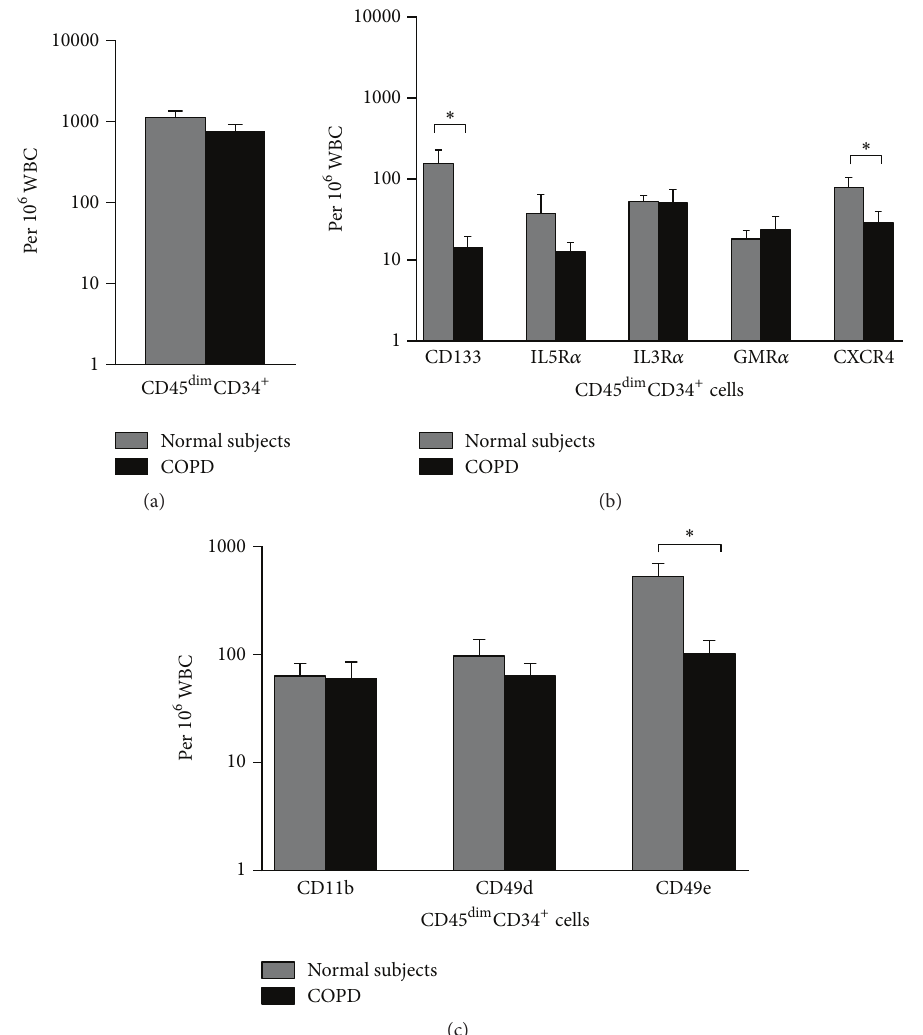
Figure 1: (a) Enumeration, (b) phenotyping, and (c) assessment of adhesion receptors by flow cytometry on blood HPC progenitor cells collected from COPD patients ( 𝑛 = 9 ) and normal nonatopic controls ( 𝑛 = 8 ). Data are presented as mean ± SEM; ∗ 𝑝 < 0.05 between group